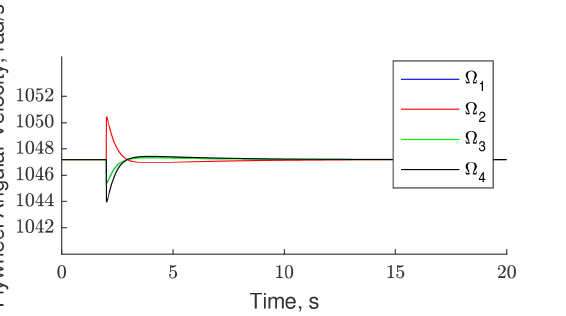
Figure 6. Angular velocity of each flywheel in the variable speed control moment gyroscope (VSCMG) cluster with null motion.